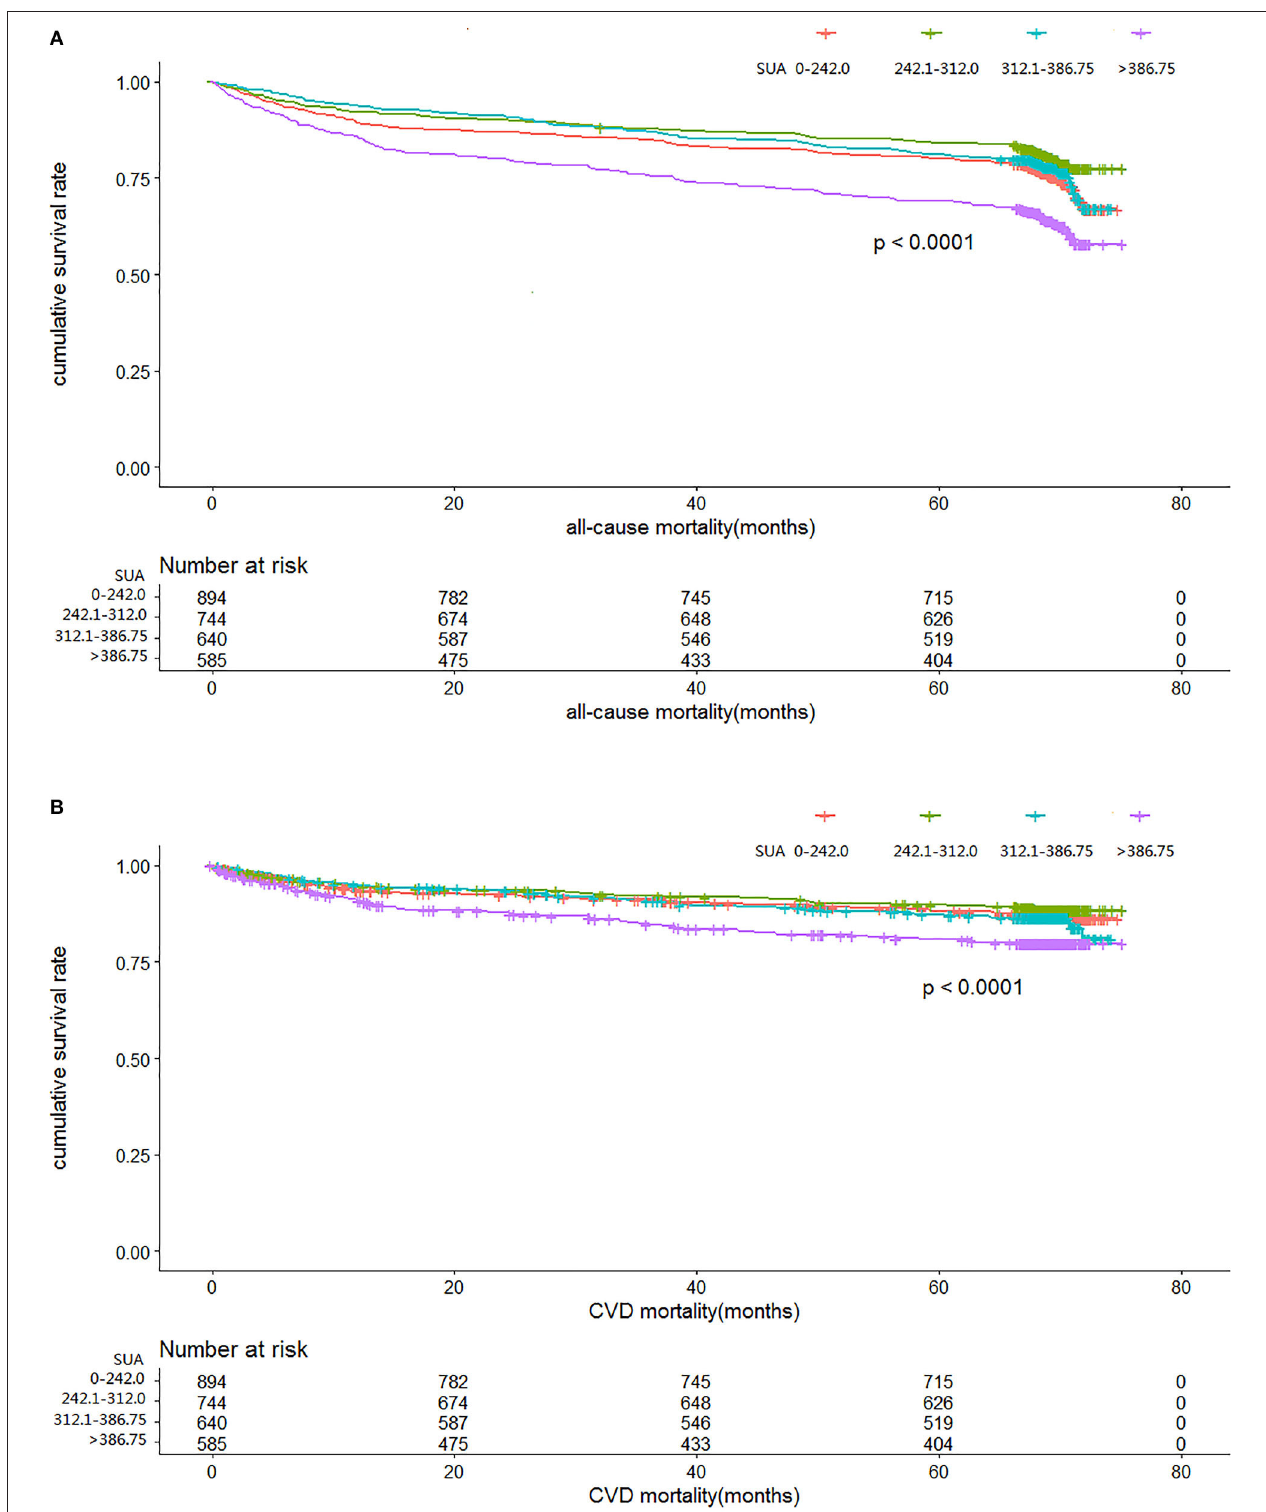
FIGURE 2 | Time course to death from all causes (A) and cardiovascular disease (CVD) (B) according to serum uric acid level in the cohort study during 6-year follow-up.